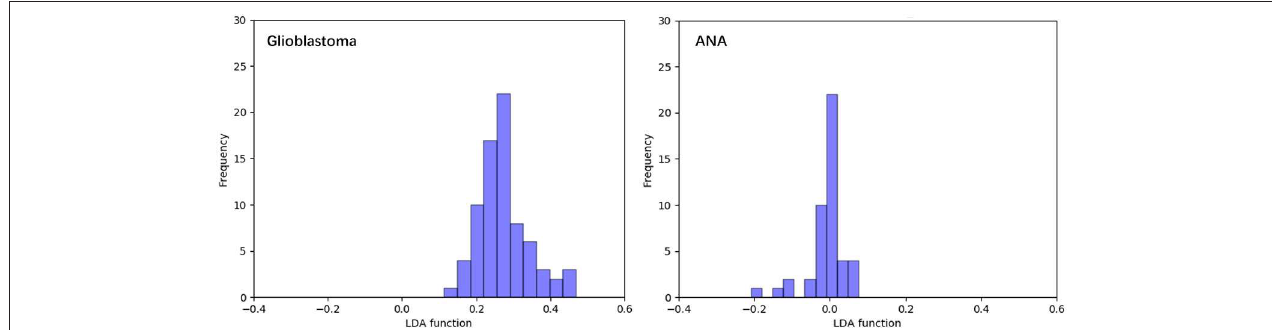
FIGURE 4 | Distribution of the direct LDA function determined for the glioblastoma and ANA for one of the 100 independent training cycles in the data analysis to illustrate the performance of the LASSO + LDA model. There were clear shifts of LDA function values, with left shift for ANA and right shift for glioblastoma. The minimal overlap is observed between the two groups and a strong qualitative similarity is apparent between the plots for cycles and triangles. LDA, linear discriminant analysis; ANA, anaplastic astrocytoma; LASSO, least absolute shrinkage and selection